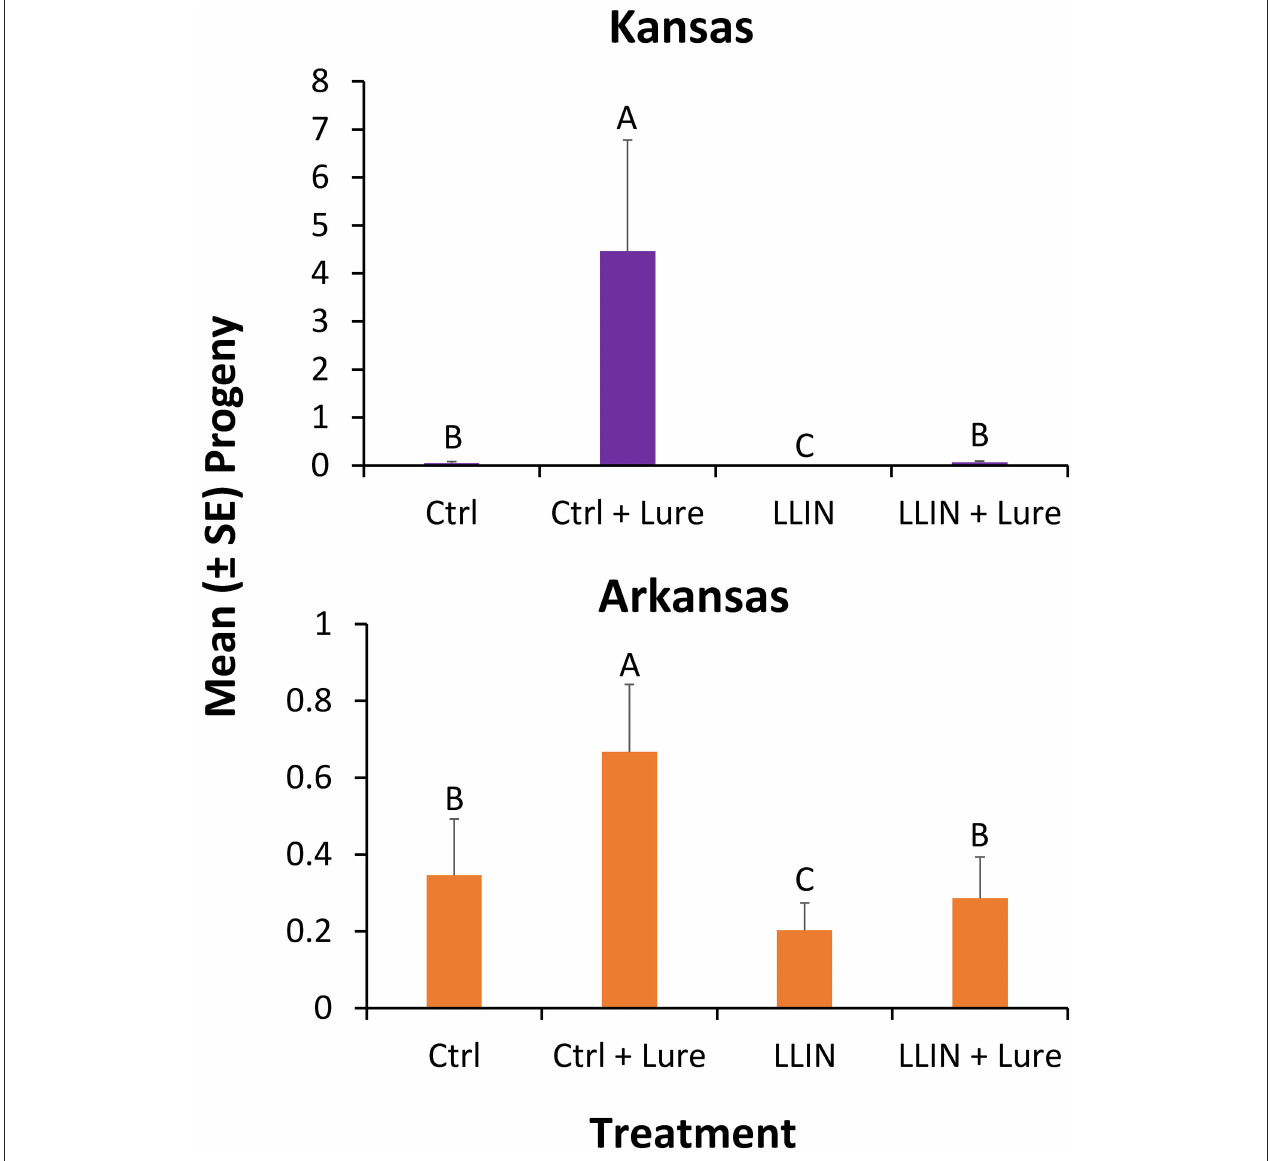
FIGURE 7 | Mean number progeny ( ± SE) produced by stored product insects ovipositing prior to succumbing to the treatments after 6 weeks from grain inside traps deployed for 48-h periods once every other week at six sites during 2018 and 2019 in in Kansas (top) and Arkansas (bottom) at commercial food facilities. Bars with shared letters are not significantly different from each other ( χ 2-test, Bonferroni